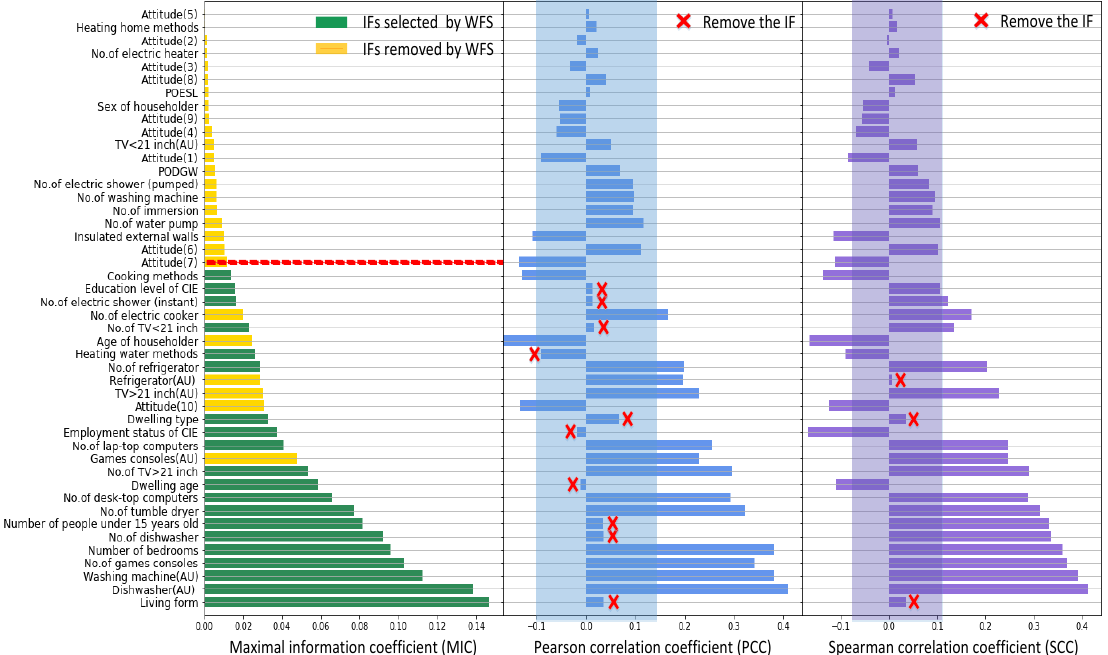
Figure 7. The MIC, PCC and SCC between each IF and RECL are respectively shown in the above three subplots. In the first subplot, green represents that the corresponding IFs is selected by WFS and yellow represents that the corresponding IFs is removed by WFS. In the second subplot, the blue shaded area is the removing range based on PCC and the red symbol “×”means to remove the IFs that is inside the shadow area. The function of the third subplot is same as the second one.